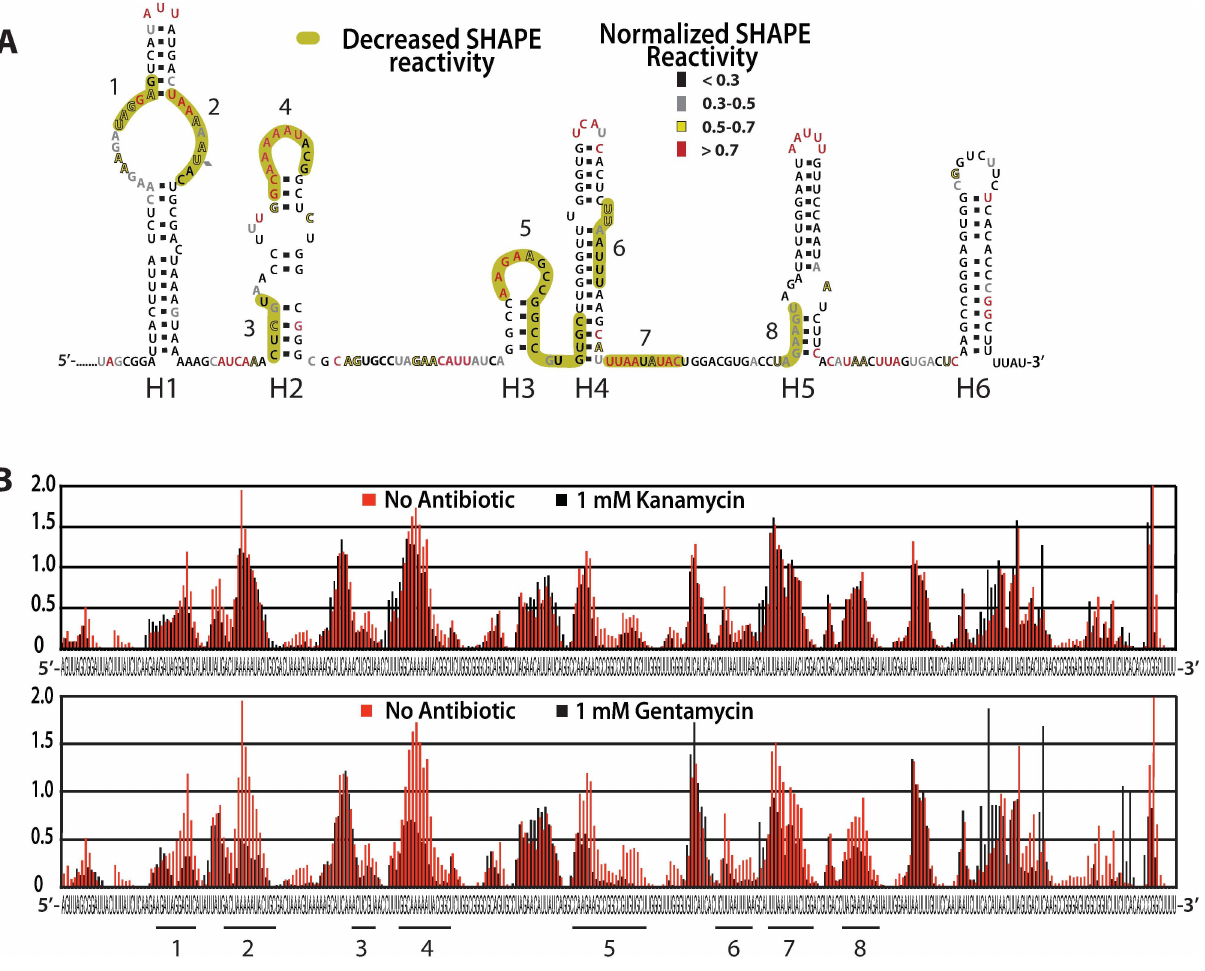
Fig 5. Interactions of aminoglycosides with Ysr170were investigated using SHAPE probing. (A) 500 nM sRNA was titrated with 1mM of antibiotic. Nucleotideswith high SHAPE reactivity are shown in red and nucleotides with low reactivity are shown in black. Helix 1 (H1) contains4 internalloops/bulges and is cappedby a AUU triloop with UA neck base pair. Helix 2 (H2) containsa large internalloop/bulge,a single adeninebulge,and is cappedby a 9-nucleotide loop. Helices 3 (H3) and 6 (H4) containno internalloops and are both capped by 8-memberloops (note that helix 6 containsa single AA bulge). Helix 4 (H4) containsa 1–2 bulge and is capped by a tetraloop. Finally, helix 5 (H5) containsa 4–2 internalloop and is capped by a pentaloop.Proposedsecondary structure showingregionswith reducedSHAPE reactivity in the presenceof gentamycin is shown in gold. (B) Comparisonof normalized SHAPE reactivity for Ysr170 betweenreactions in the presence(black) or absence(red) of kanamycin(upper)or gentamycin(lower).